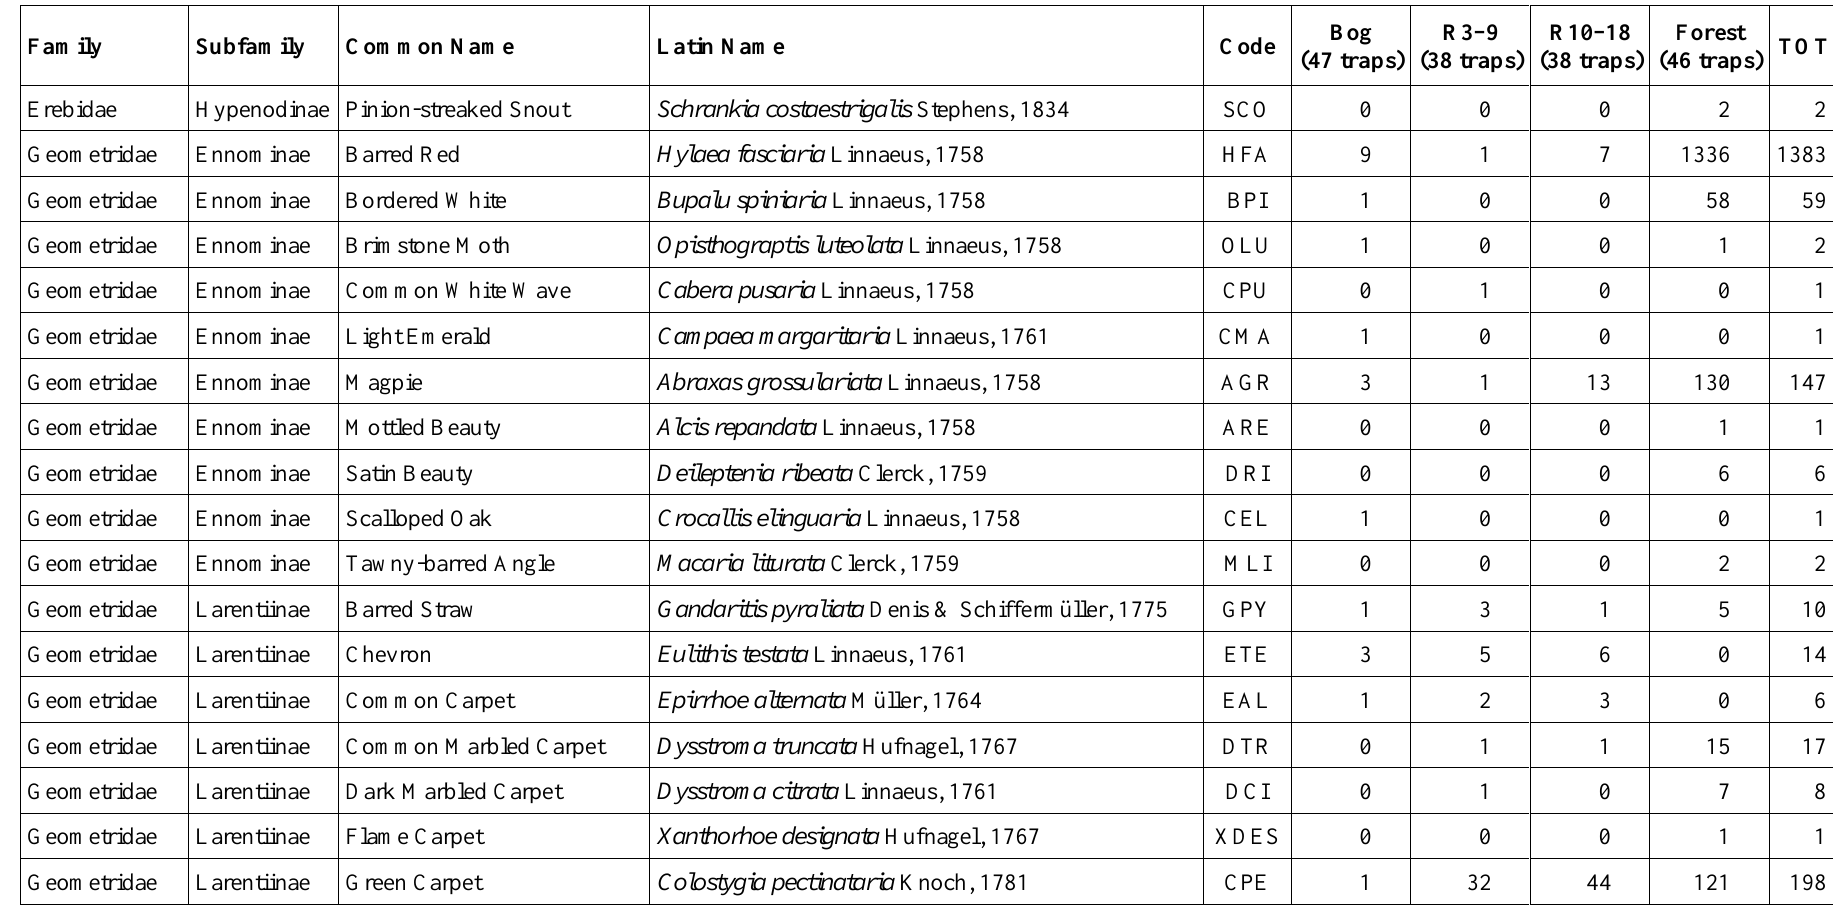
Table A1. List of moth species trapped at Forsinard (nomenclature follows Agassiz et al . 2013). R3–9 and R10–18 refer to restoration plots three to nine years and ten to eighteen years, respectively, after the onset of restoration at time of